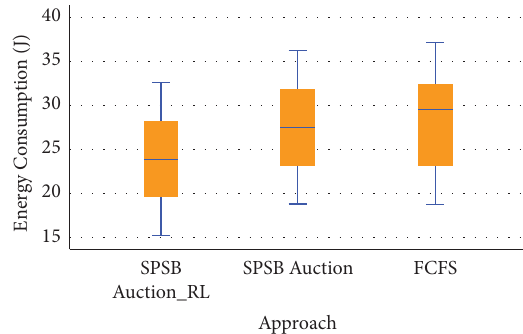
Figure 9: Te variance of the energy consumption for diferent approaches.